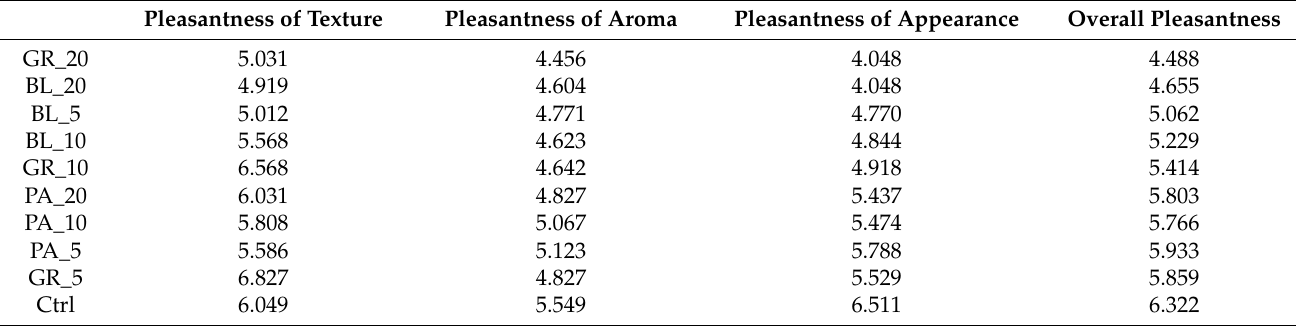
Table 4. Adjusted mean of hedonic evaluation of edible